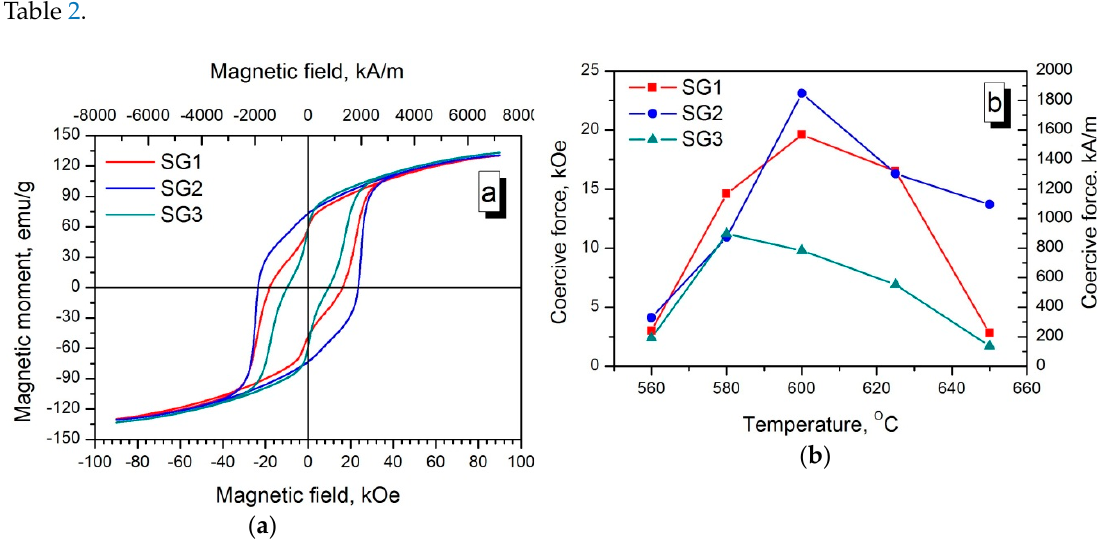
Figure 6. Hysteresis loops of samples annealed at 600 °C for 30 min ( a ) and the dependence of coercivity on the annealing temperature ( b ).